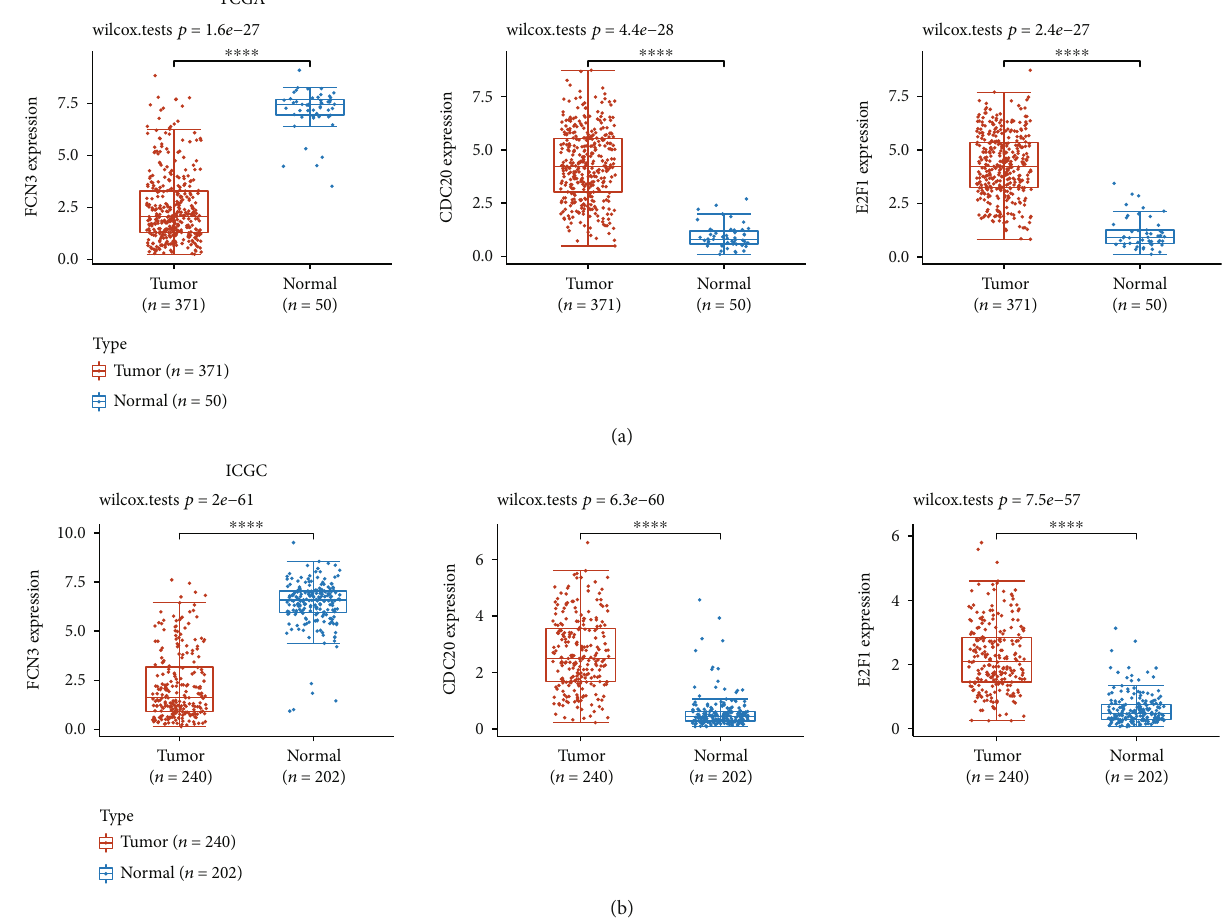
Figure 9: The expression of the critical genes having a correlation with survival in HCC. The FCN3 expression was noticeably reduced in HCC specimens, while CDC20 and E2F1 showed a decreased expression based on (a) TCGA datasets and (b) ICGC